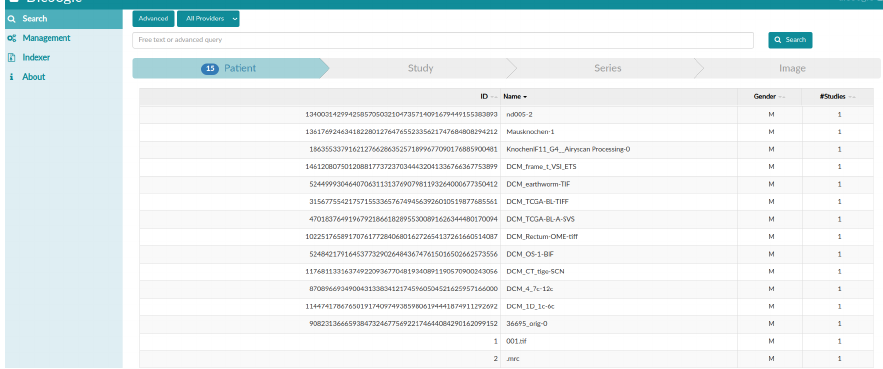
Figure 13. Dicoogle PACS shows that the files in the eight distinct proprietary file formats were successfully indexed by the